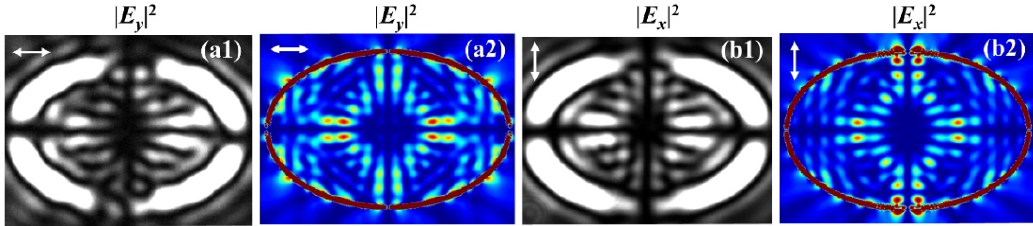
Figure 8. Experimental ( a1 , b1 ) and simulation ( a2 , b2 ) intensity maps of | E y | 2 under the x -linearly polarized (LP) illumination ( a1 , a2 ) and | E x | 2 under the y -LP illumination ( b1 , b2 ), respectively.